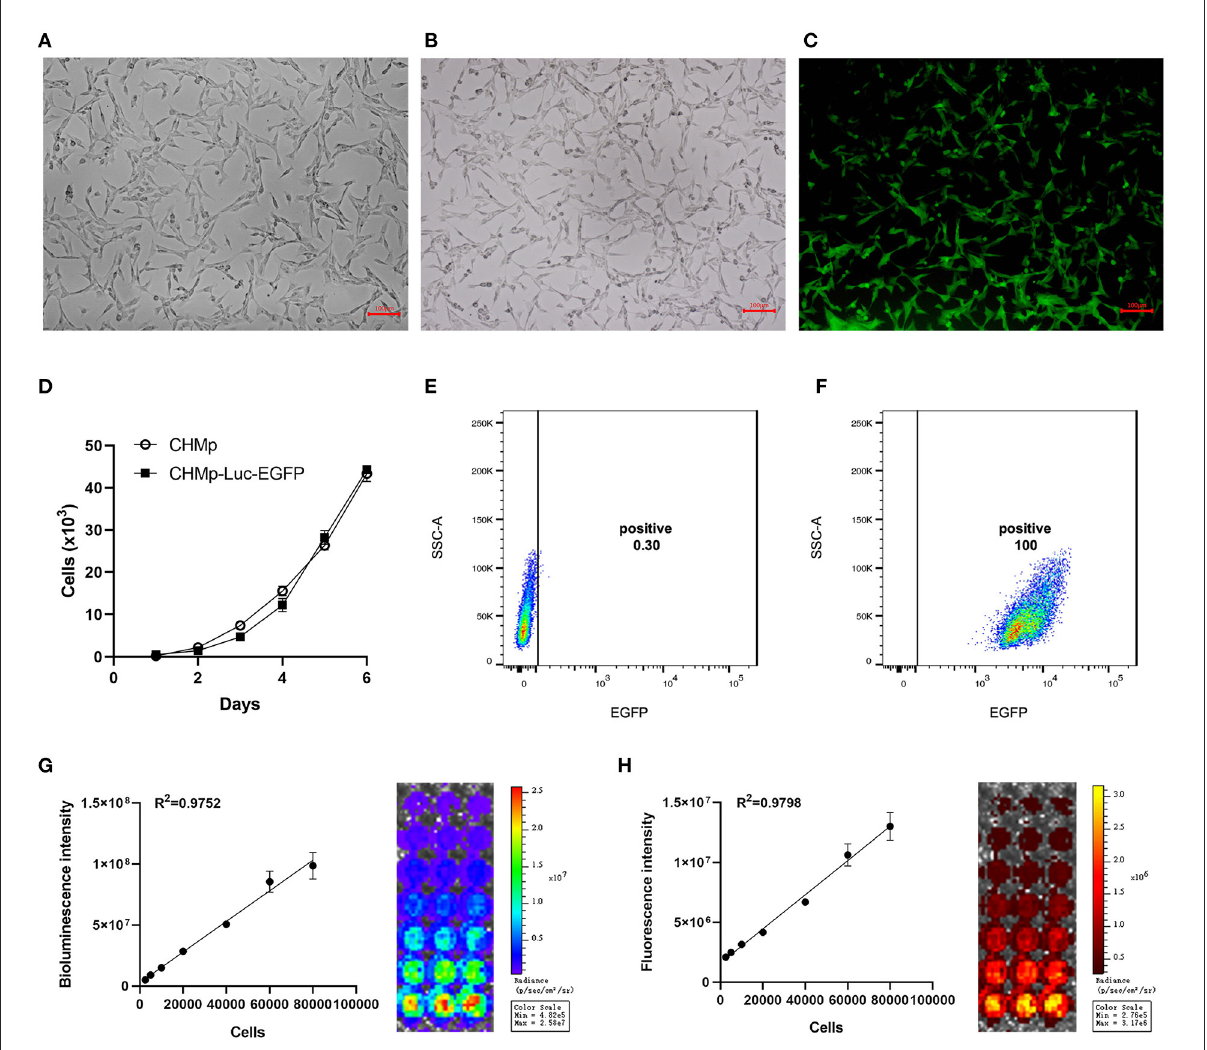
FIGURE1 Establishment of the CHMp-Luc-EGFP cell line. (A) Morphological features of CHMp. (B,C) White-light and fluorescence images of CHMp-Luc-EGFP cells were captured. Magnification × 10; scale bar, 100 µ m. (D) Growth curves of CHMp and CHMp-Luc-EGFP cell lines. Data are the mean of five repeat experiments. Each value is the mean ± SD. (E,F) EGFP expression of CHMp and CHMp-Luc-EGFP. (G) Bioluminescence of cells and correlation analysis between bioluminescence intensity and cell density. (H) Fluorescence of cells and correlation analysis between fluorescence intensity and cell density. Each value is the mean of three repeat experiments, mean ± SD.